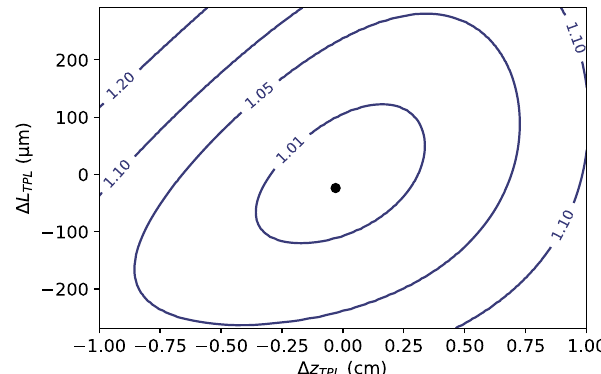
FIG. 2. Contour plot of the PWFA matching parameter B m over a range of errors in the plasma lens thickness Δ L and plasma TPL lens location Δ z . A tolerance of 1% saturated emittance TPL growth, corresponding to the B m ¼ 1 . 01 contour, permits an error of up to (cid:3) 100 μ m and (cid:3) 0 . 3 cm in the lens thickness and position, respectively. The filled circle represents the parameter set of the thin lens used in Fig. 1 with B m ¼ 1 . 0004 and the axis origin represents the perfect matching value.